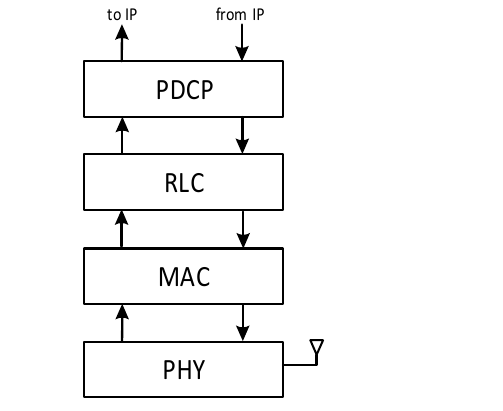
Figure 1. LTE-A (Long-Term Evolution-Advanced) protocol stack. IP: Internet Protocol; PDCP: Packet